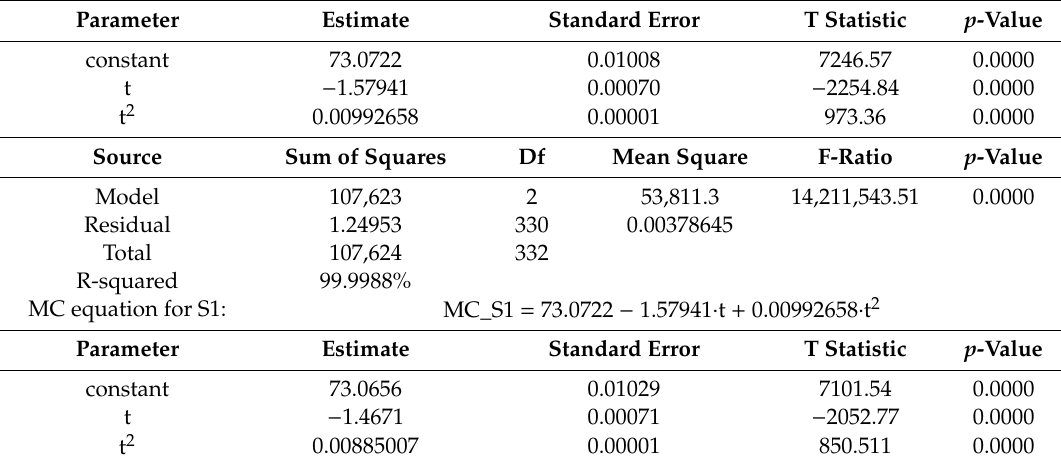
Table 2. Polynomial regression analysis results for moisture content MC as a function of time for